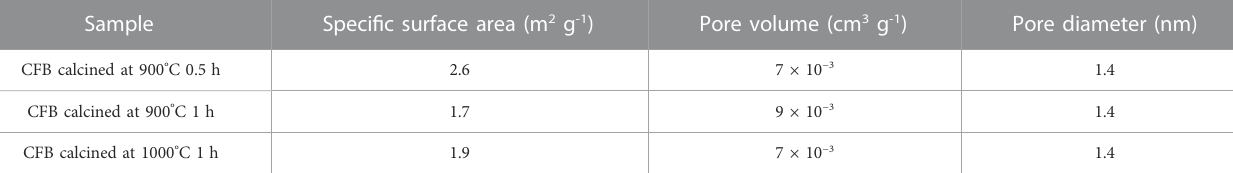
TABLE 1 Surface area and pore diameter calculation for calcined CFB at 900 ° C for 30 min and 60 min and calcined CFB at 1000 ° C for 30 min and 60